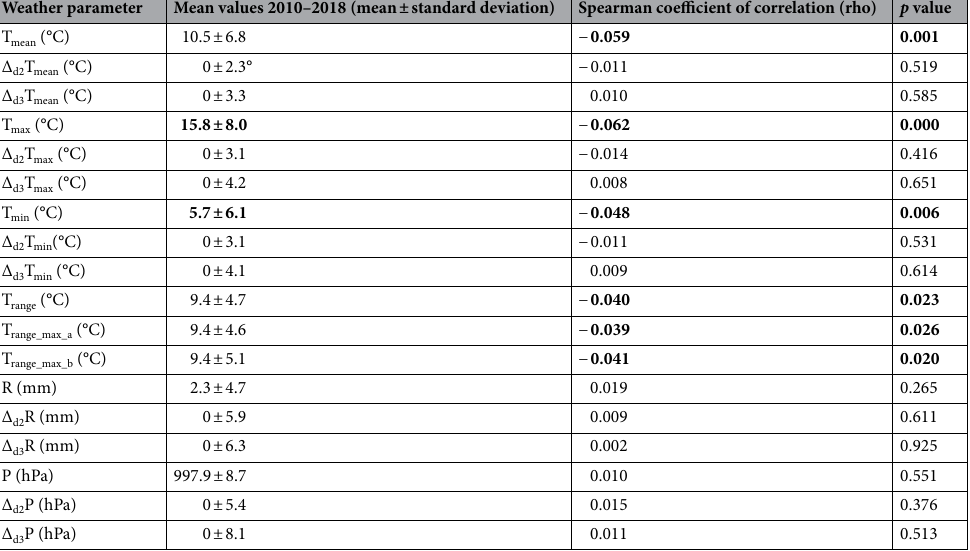
Table 1. Correlation analysis (Spearman) of meteorological parameters obtained from three weather stations in the central Ruhr Region, Germany, between 2010 and 2018 and daily admissions for hypertensive disease. p < 0.05 was regarded significant (bold type). T—temperature, R—rainfall (precipitation), P— athmospheric pressure; Δ d2 —change within two days, Δ d3 —change within three days, T range : daily range of temperature, T